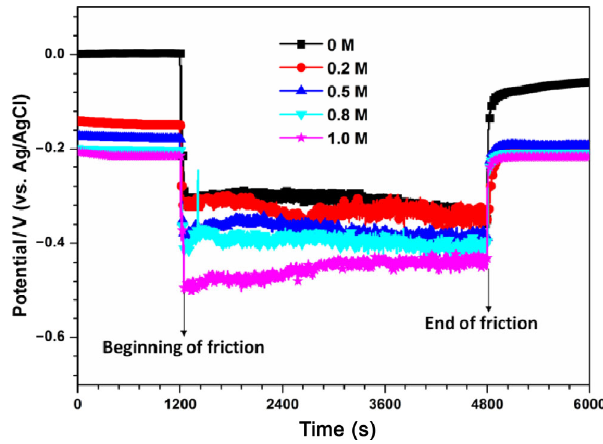
Fig. 2 OCP curves of NAB alloy in artificial seawater with different halide-ion